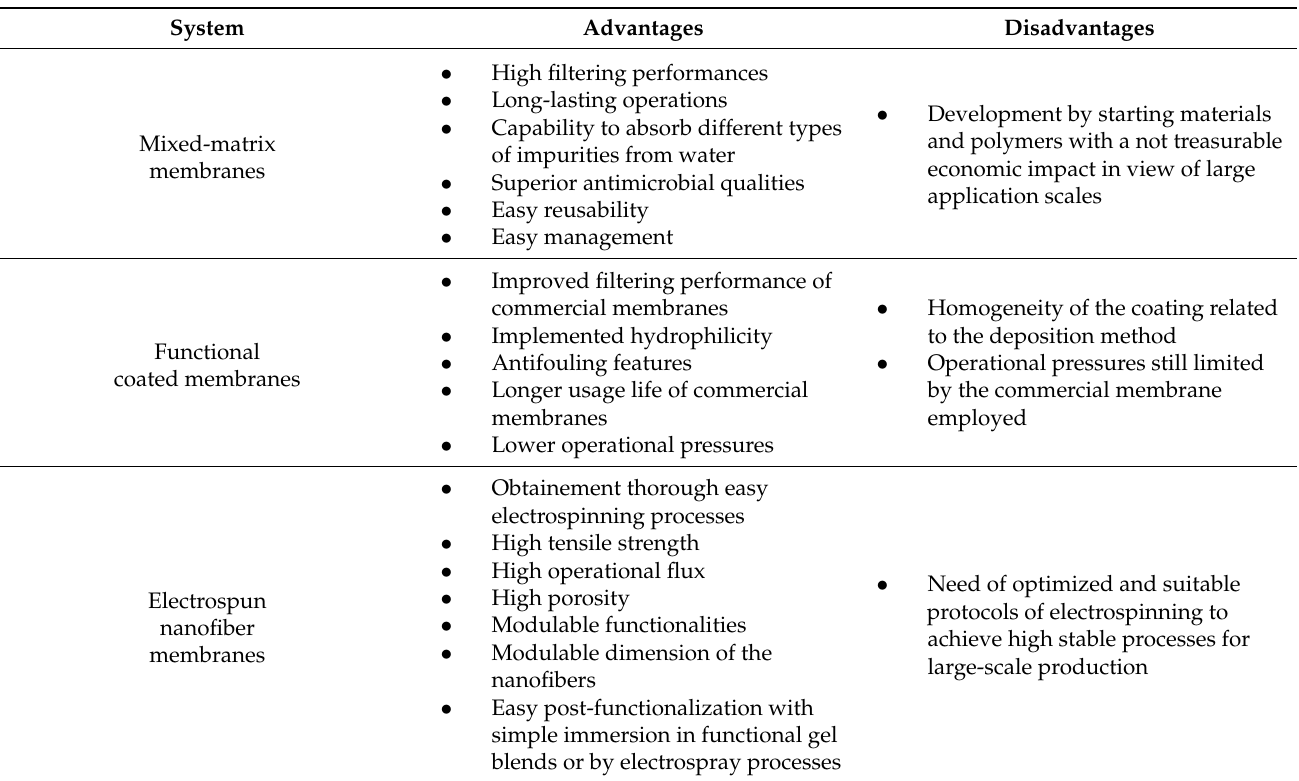
Table 6. Comparison of the advantages and disadvantages of the technologies and approaches related to sustainable filtration membranes described in this